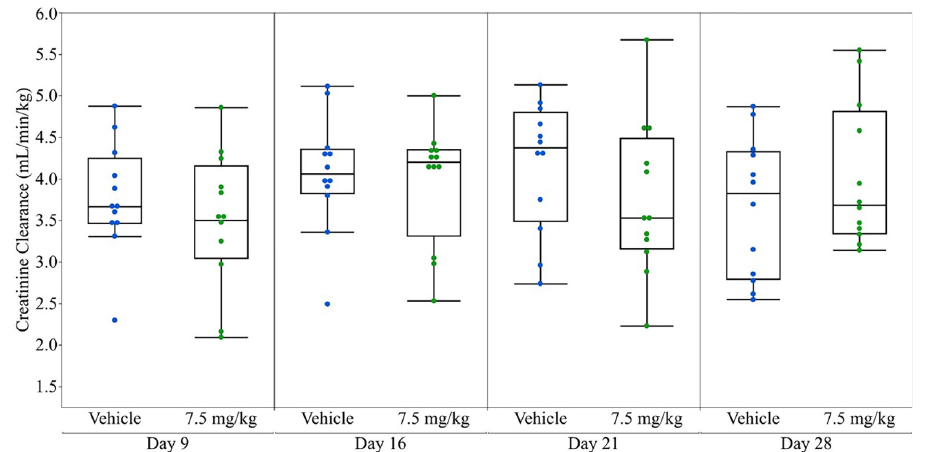
Fig 2. Creatinine clearance (mL/min/kg) in control and anti-Fx1A-treated rats. Outlier boxplot: Horizontal line within the box represents the median sample value, box represents interquartile range (IQR), whiskers extend to 1.5x